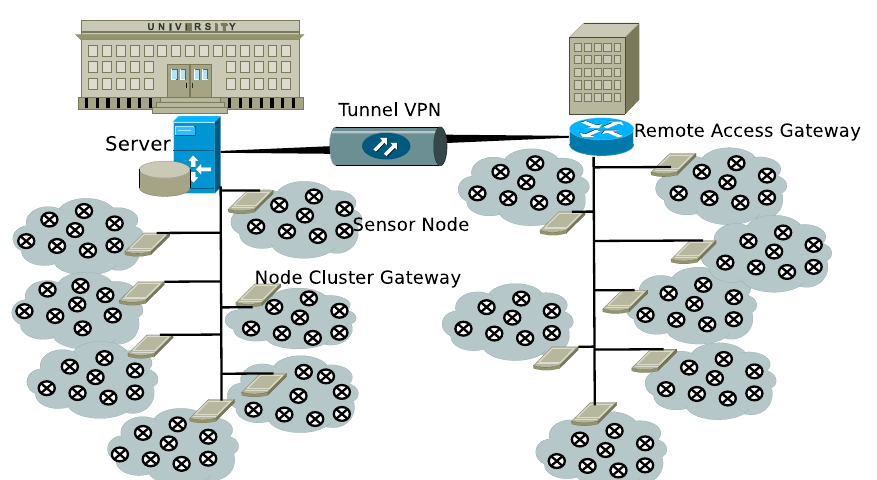
Figure 1. Campus-wide system